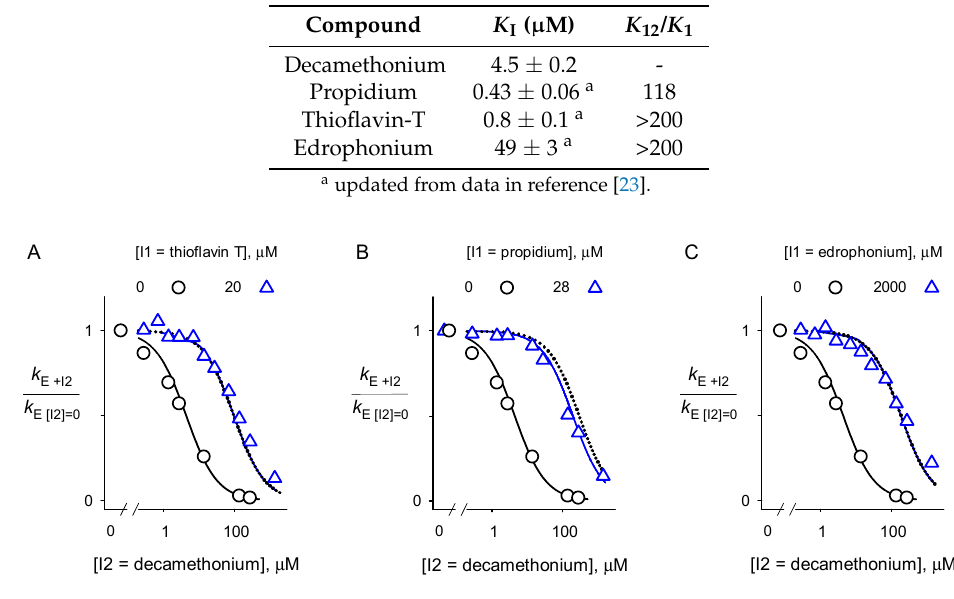
Figure 6. Analyses of relative second order rate constants for substrate hydrolysis by BChE with decamethonium (I2) in the presence (triangle) or absence (circle) of another inhibitor (I1) ( A – C ). Values of k E were obtained with Equation (1). K 2 for decamethonium was fitted to Equation (5) with [I1] = 0 (solid curves on left of each panel). K 1 for the other inhibitors was obtained in similar fashion from Equation (5) (Table 1). K 12 for decamethonium was fitted to Equation (5) with the [I1] indicated in each panel (solid curves on right of each panel). All experiments were performed in triplicate and the values were averaged. Dotted lines represent the theoretical plot that denotes complete competition between I1 and I2 (i.e., 1/ K 12 fixed at 0). Each plot with both I1 and I2 is essentially superimposable with the dotted curves that indicate complete competition (i.e., 1/ K 12 ≅ 0). The fitted values of the affinities of I1 and I2 in the binary complexes relative to those in the ternary complex ( K 12 / K 1 = K 21 / K 2 ) are shown in Table 1. Table 1. Inhibition constants ( K I ) for four inhibitors with BChE and binding site competition ratios ( K 12 / K 1 ) for each inhibitor in the presence of decamethonium. A K 12 / K 1 ratio >> 1 denotes competition at the same binding site.